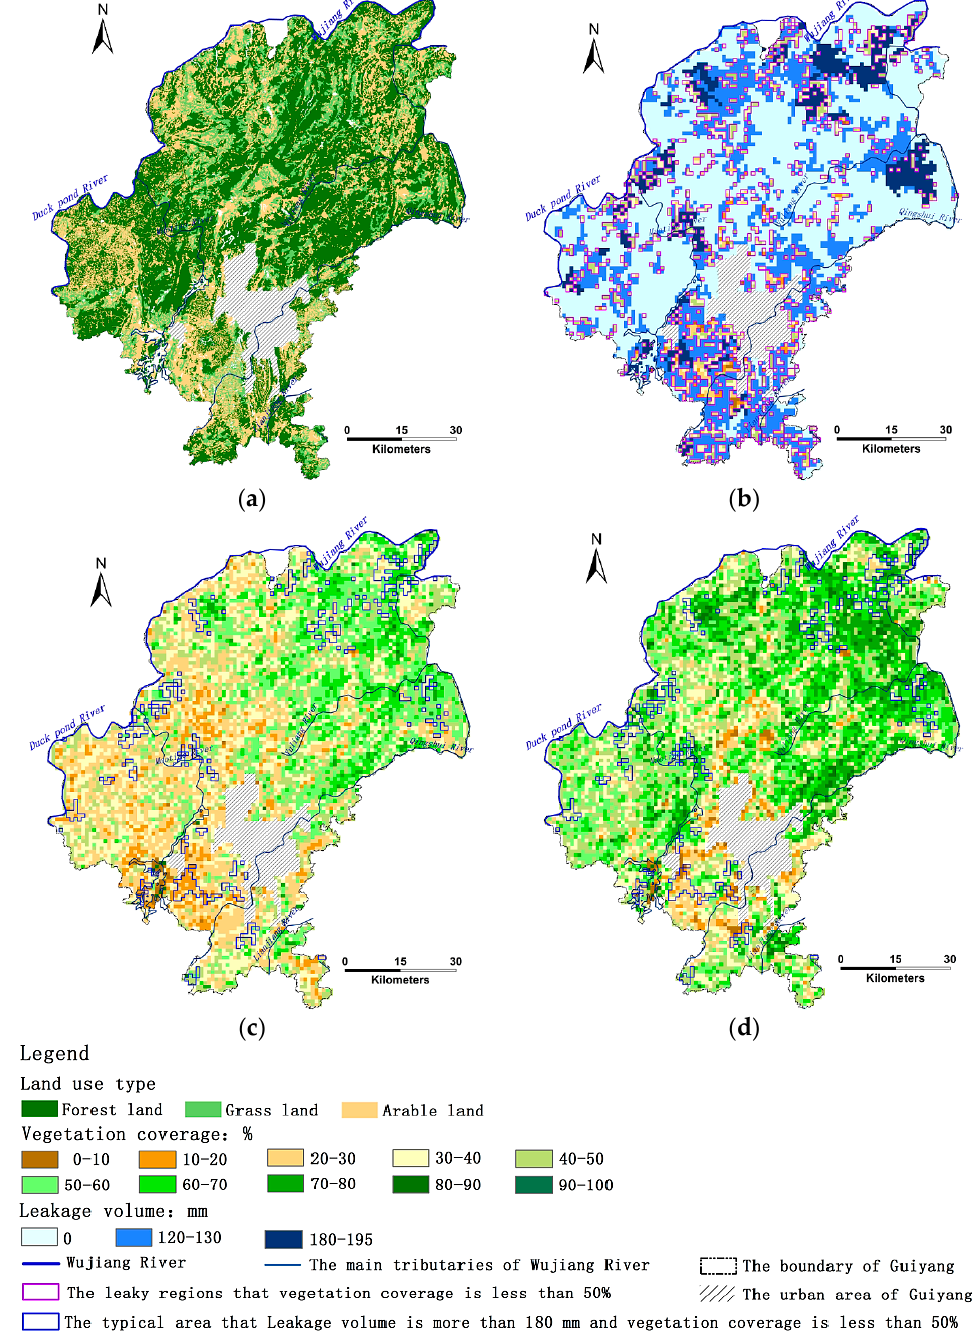
Figure 10. ( a ) The type of land use; ( b ) leaky regions where vegetation coverage is <50% and land use cover is forest and grassland in 2013; and ( c ) vegetation coverage in 2003; and ( d ) in 2013. As shown in Figure 10a,b, the leaky area where vegetation coverage is <50% and land use is forest and grass is 1248 km 2 , which accounts for 50.88% of the leaky forest and grassland, and for 32.80% of the entire leaky area (3805 km 2 ).